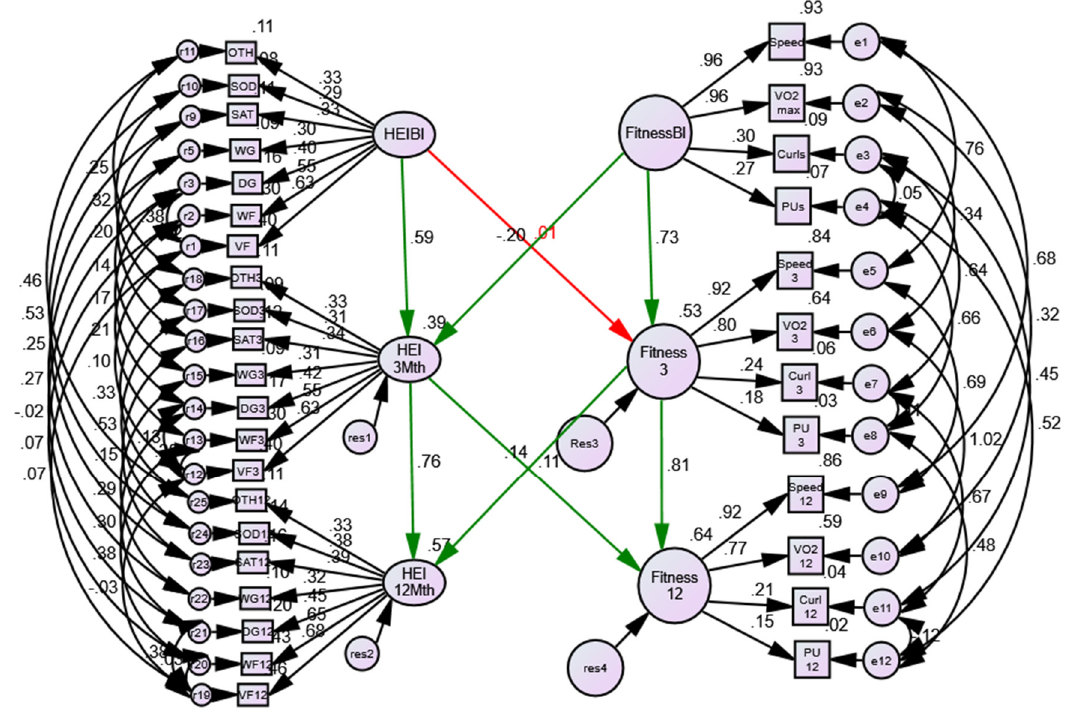
Figure 6. Overall sex and time invariant results showing structural regressions between HEI and Fitness factors. Regression paths in green show significant results, structural regression in red were not statistically significant. FitnessB1 = baseline; Fitness3 = 3-months; Fitness12 = 12-months Speed = treadmill speed; VO 2 max = age-sex percentile; Curls = Curl-ups; PU = Push-ups. HEIBl = total HEI-C baseline; HEI3Mth = total HEI-C at 3-months; HEI12Mth = total HEI-C at 12-months; VF = total vegetables and fruit; WF = whole fruit; DG = dark green and orange vegetables; WG = whole grains; SF = saturated fats; SOD = sodium; OTH = Other foods; e# and r# = error terms.